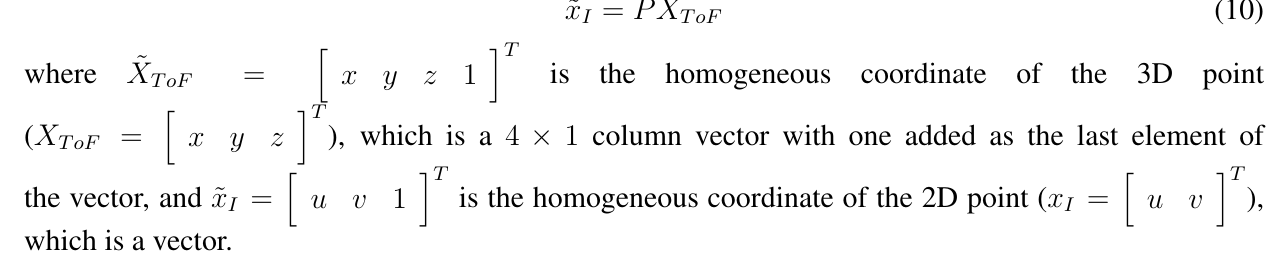
Figure 5. The proposed system can be divided into off-line and on-line